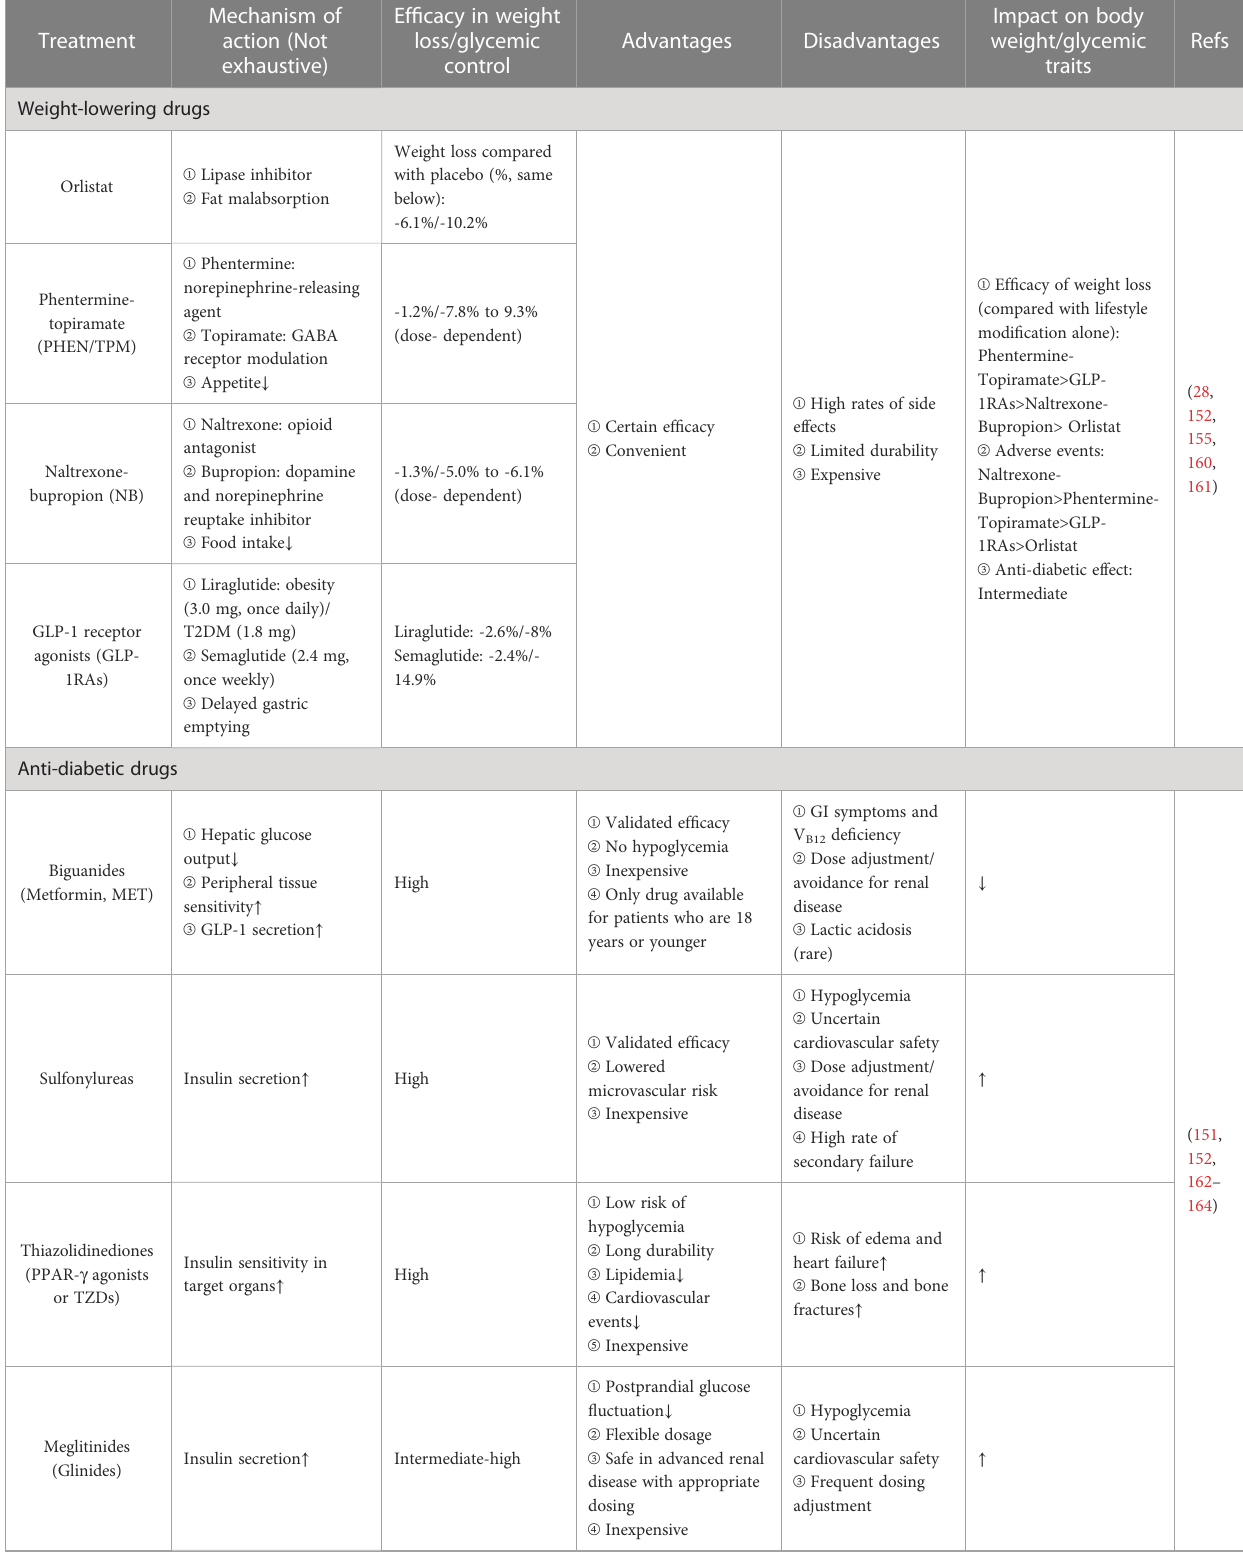
TABLE 1 The mutual effects of weight-lowering drugs and anti-diabetic drugs on managing obesity and